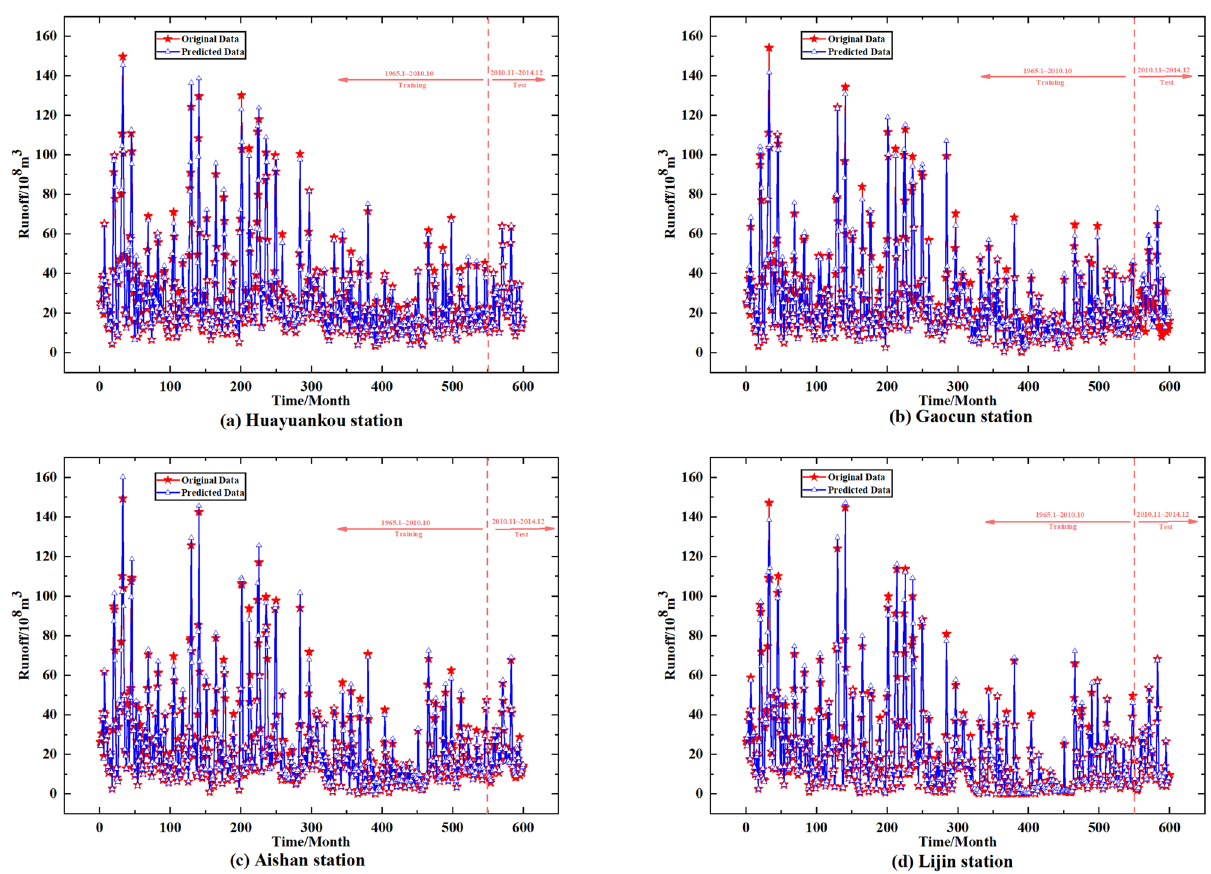
Figure 8. CEEMDAN–LSSVM–GM(1,1) model predicts monthly runoff results for stations under the Yellow